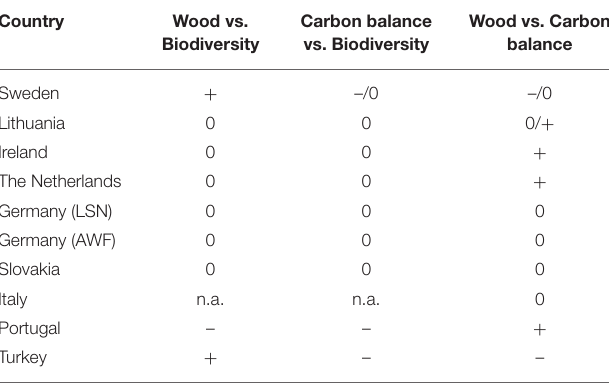
+ + – – The symbols “ + ”, “–”, “0” indicate correlations we interpret as considerably positive, negative, or not existing, respectively. Two symbols separated by a “/” means that both correlation types are observed in different scenarios of the related case